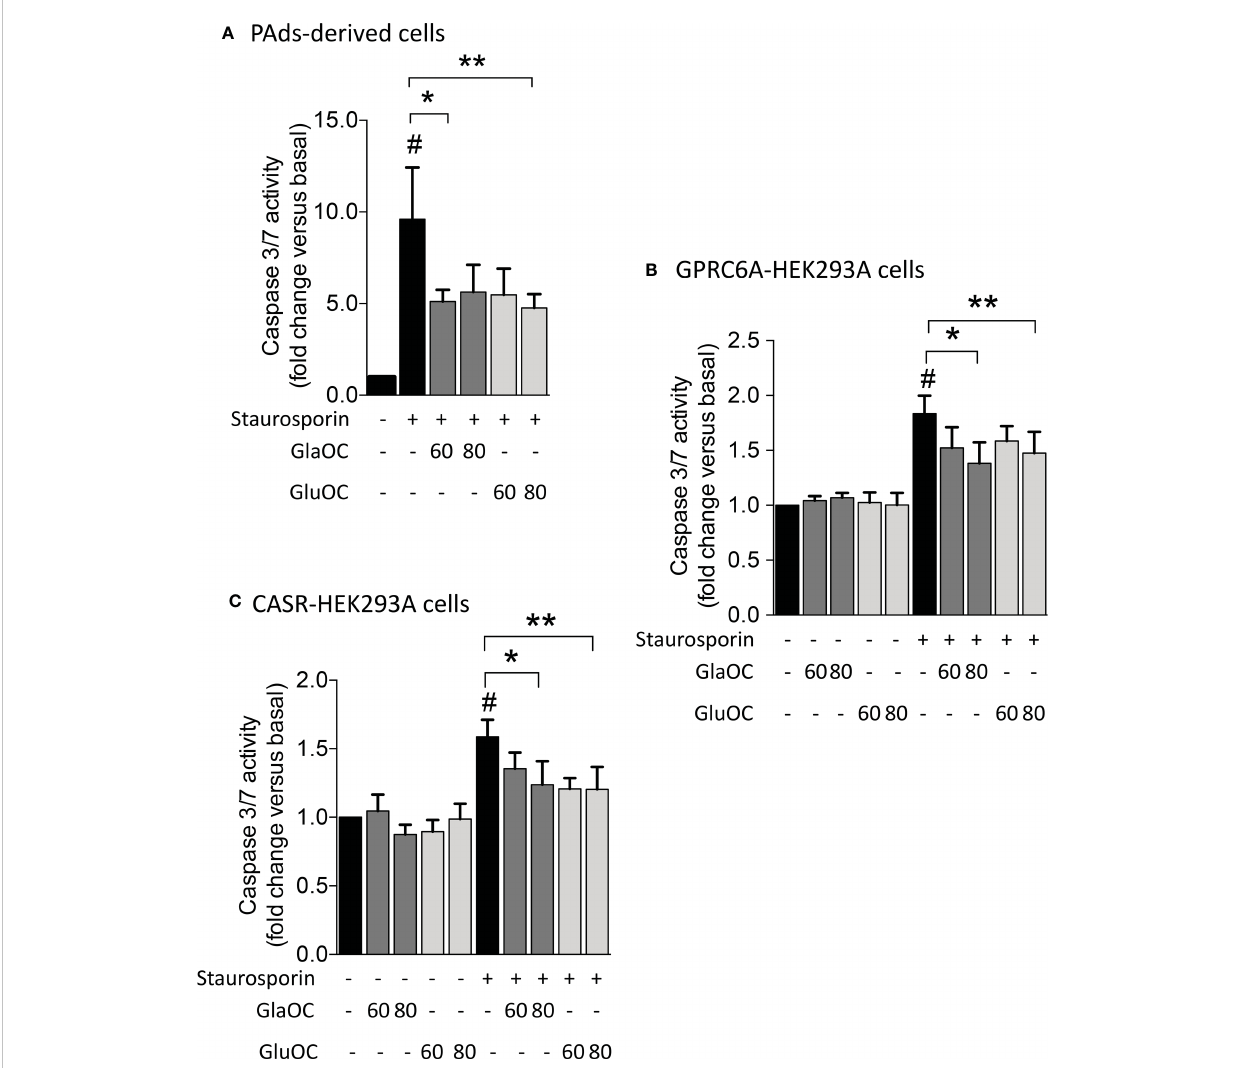
FIGURE 7 Effects of GlaOC and GluOC stimulation on staurosporin-induced apoptosis. (A) Effects of 60-80 ng/mL GlaOC (dark grey columns) and GluOC (light grey columns) on staurosporin-induced apoptosis in PAds-derived cells (#, P=0.022 versus basal levels; *, P=0.050 vs staurosporin treated cells; **, P=0.045 vs staurosporin treated cells). (B) Effects of 60-80 ng/mL GlaOC and GluOC on staurosporin-induced apoptosis in GPRC6A- HEK293A cells (#, P=0.036 vs basal levels; *, P=0.013 vs staurosporin treated cells; **, P=0.087 vs staurosporin treated cells). (C) Effects of